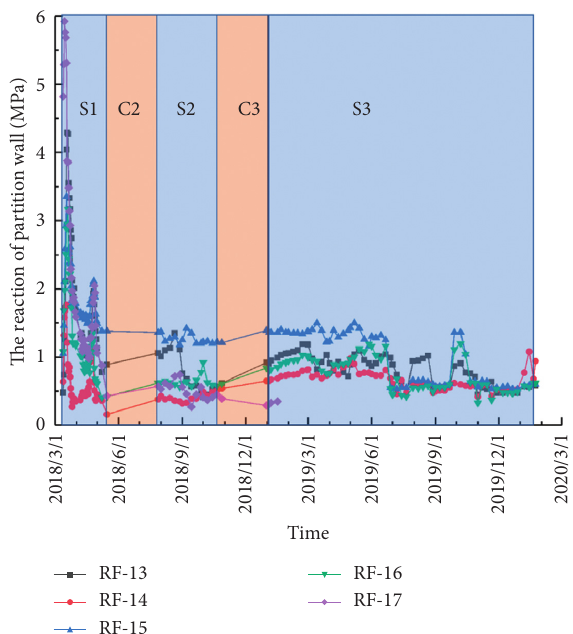
Figure 10: The change of partition wall reaction force during caisson